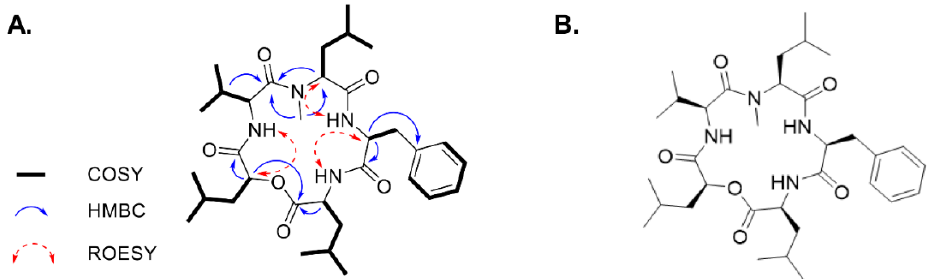
Figure 1. Structure elucidation of N -methylsansalvamide (MSSV). ( A ) Chemical structure of (COSY), HMBC, and ROESY correlations of MSSV. ( B ) Chemical structure of MSSV. ( B ) Key correlation spectroscopy (COSY), HMBC, and ROESY correlations of MSSV.